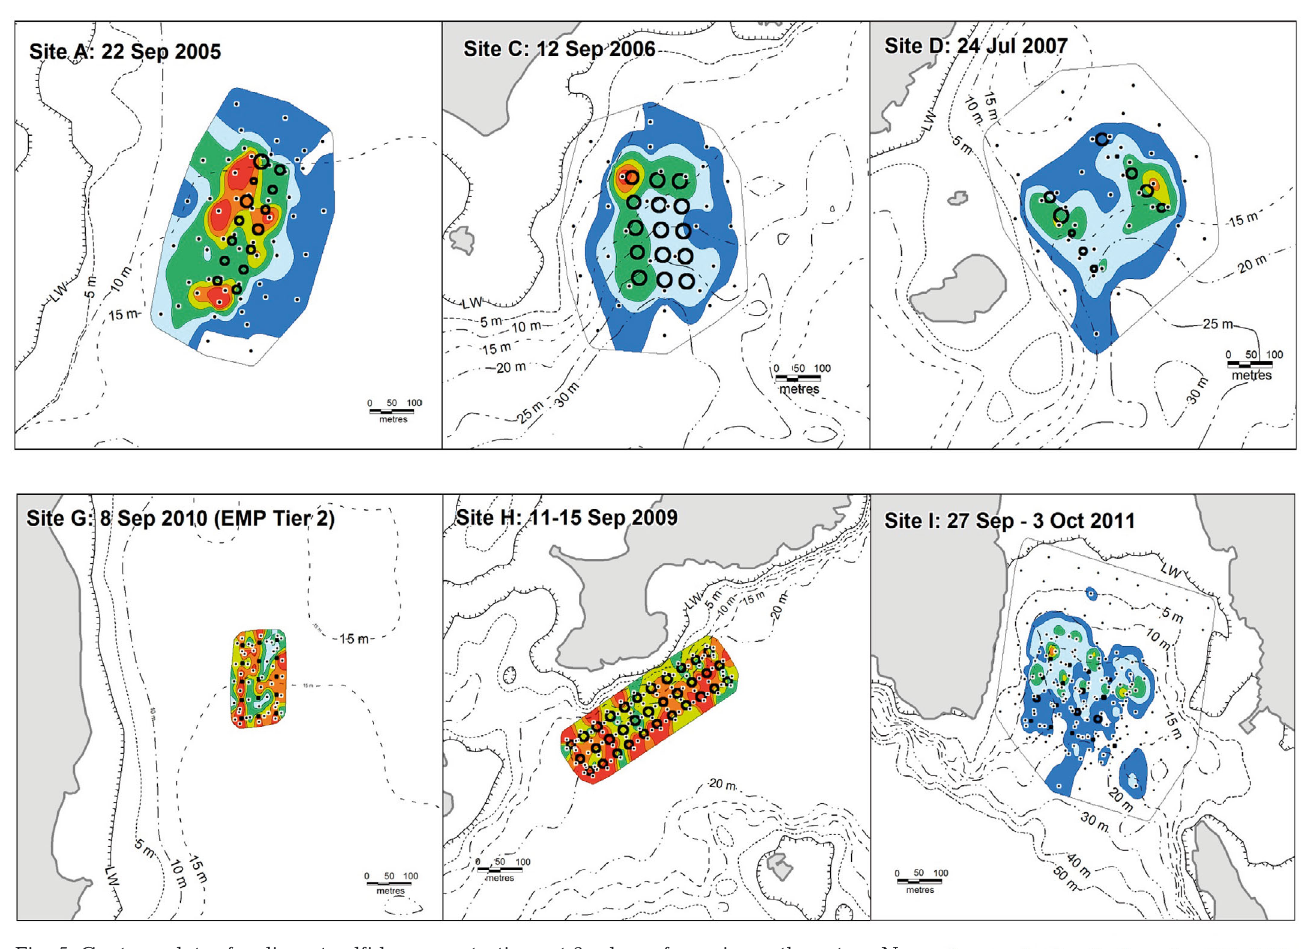
Fig. 5. Contour plots of sediment sulfide concentrations at 6 salmon farms in southwestern New Brunswick (SWNB). Black dots indicate sampling stations. Circles indicate cage locations, with circle sizes proportional to average daily feeding rates during 1 mo periods including the sedi- ment sampling date. Background sediment sulfide concentrations in SWNB are generally <300 µM, based on data collected at reference sites (away from fish farms and other pollution sources) in SWNB (Hargrave et al. 2008) and unpublished data (provided by the New Brunswick Department of Agriculture, Aquaculture & Fisheries, St. George, New Brunswick) collected since 2000 at finfish farm sites prior to the start of operations. Each plot shows a 1 × 1 km area, representing the DEPOMOD model domain. Depths are below normal lowest tide (LW). At Sites G and H, there were no sampling stations outside the cage